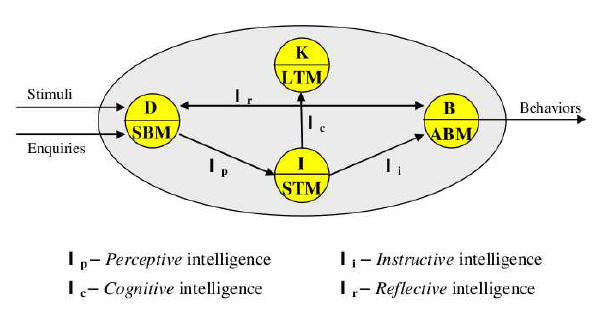
Figure 1. The Generic Abstract Intelligence Model